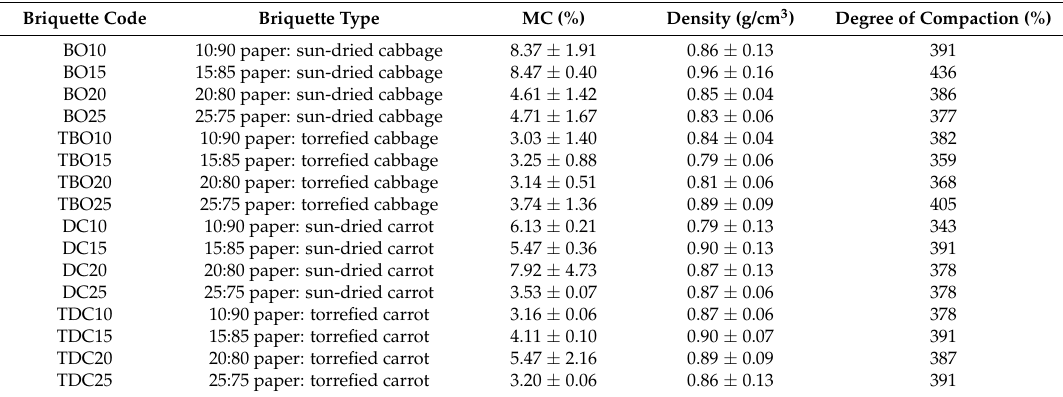
Table 4. Moisture content and densities of the